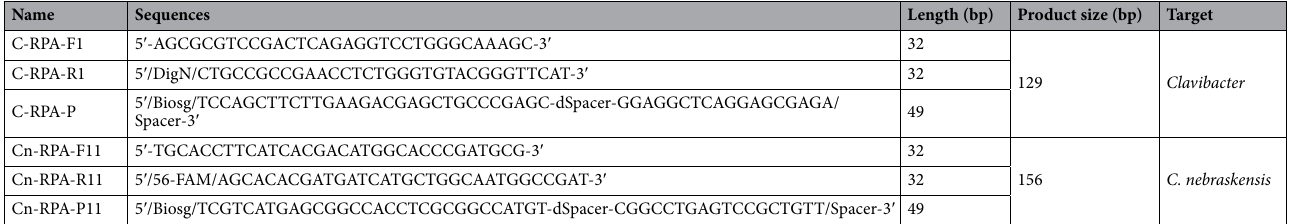
Table 2. Details of multiplex RPA primers and probes developed for specific detection of Clavibacter in general and C.